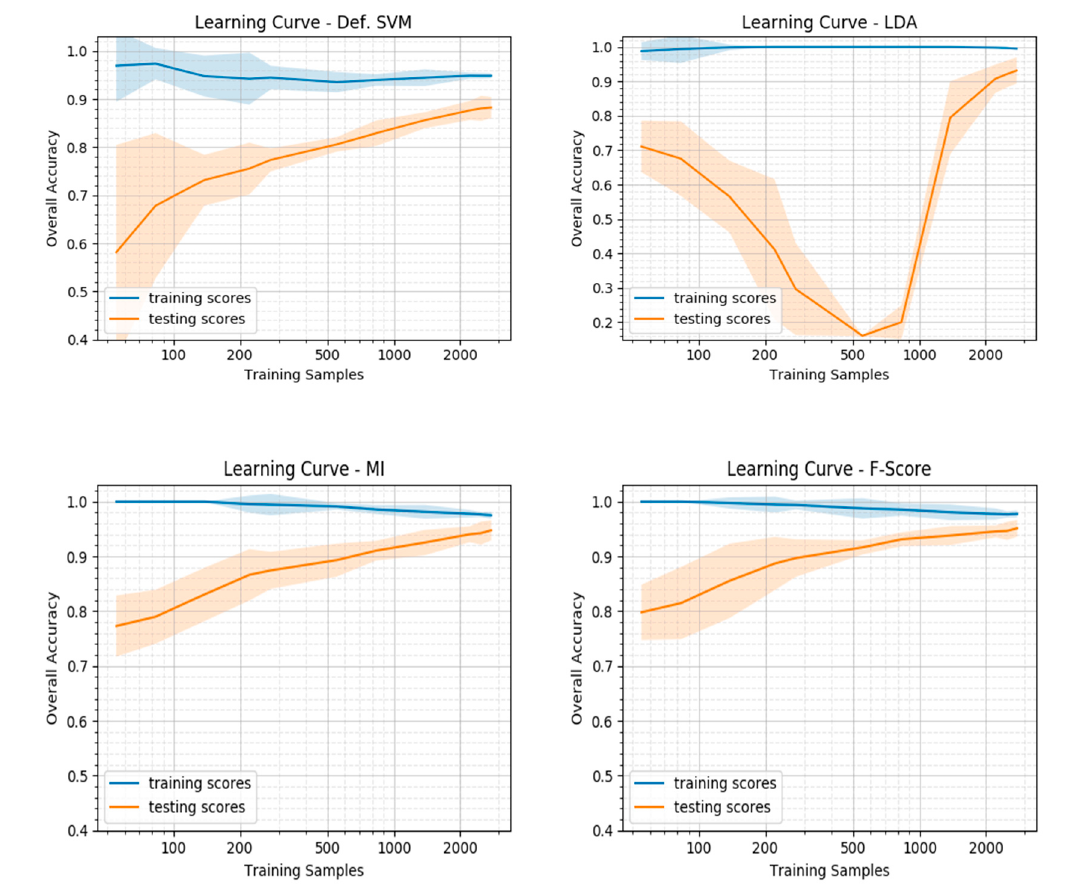
Figure 9. Learning curves showing the influence of training set sizes (Stockholm).